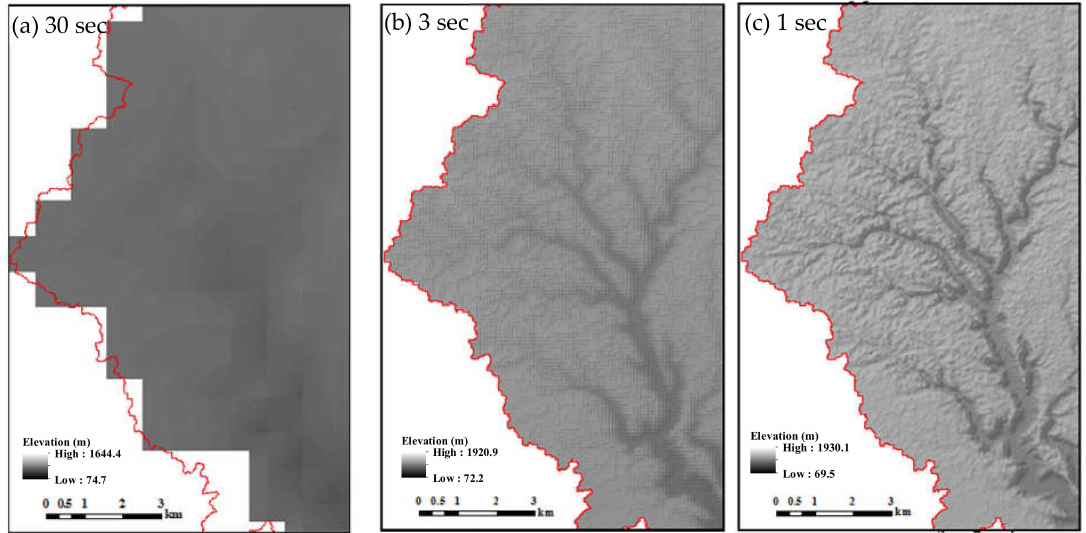
Figure 6. Comparisons between different SRTM Digital Elevation Model (DEM) data: ( a ) 30 arc-sec resolution, ( b ) 3 arc-sec resolution and ( c ) 1 arc-resolution; the last dataset captures the drainage